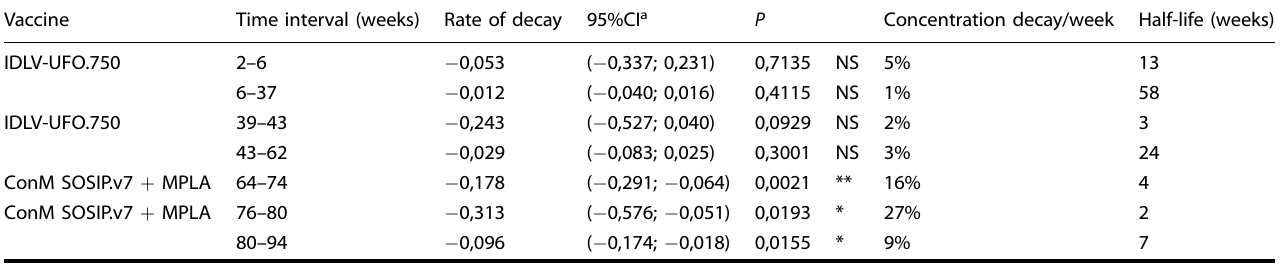
Table 1. Analysis of decay of anti-ConSOSL.UFO Env IgG response by using a piecewise linear model. Vaccine Time interval (weeks) Rate of decay 95%CI a P Concentration decay/week Half-life